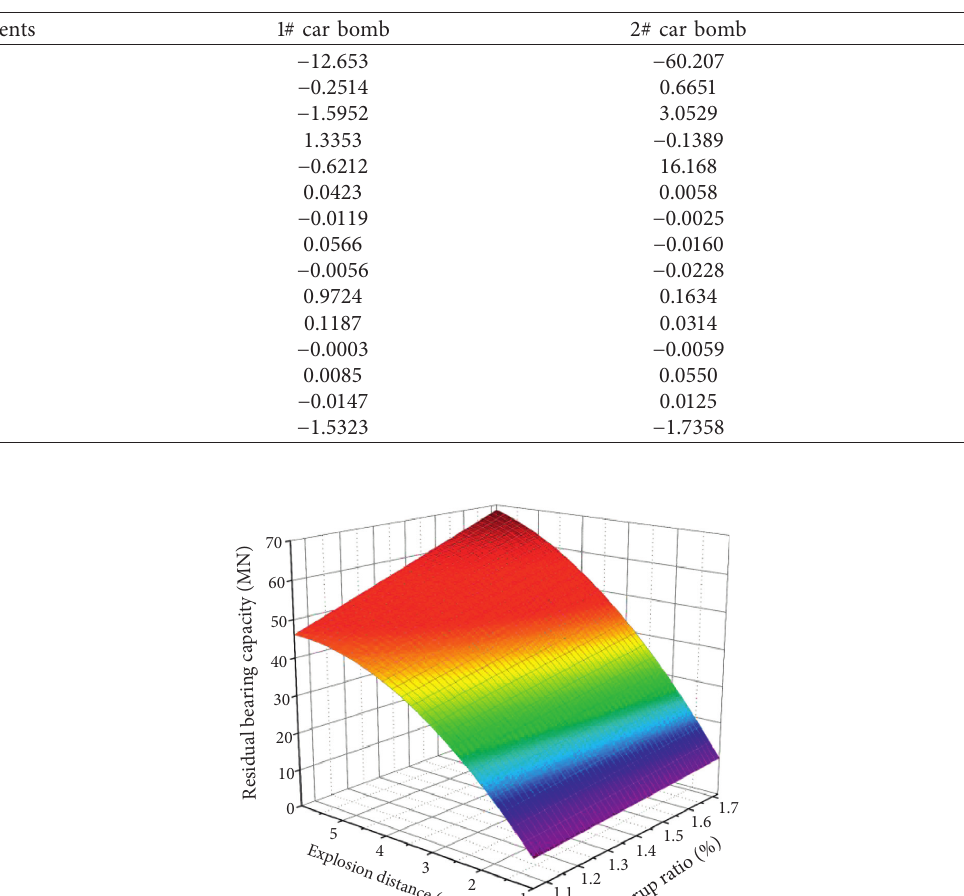
Table 8: Partial coefficients of the response surface model of pier’s residual bearing capacity.